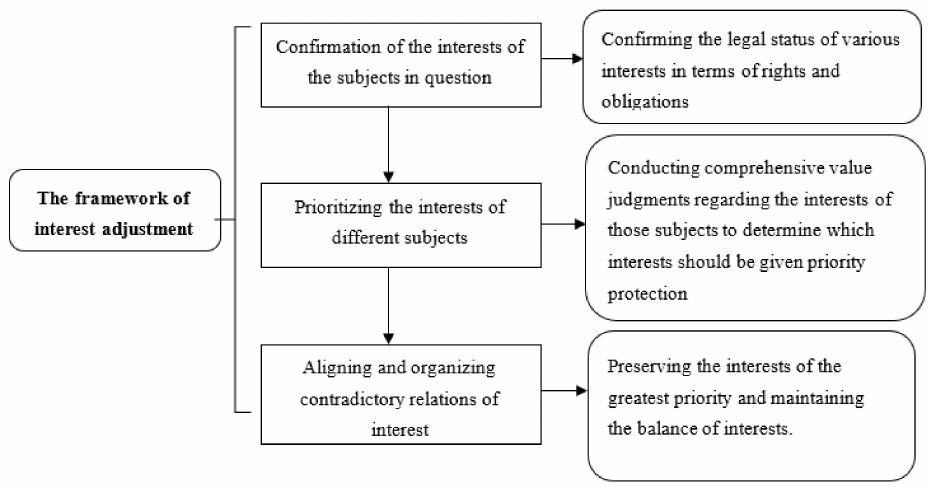
Figure 1. Framework of interest adjustment of the emergency management legal